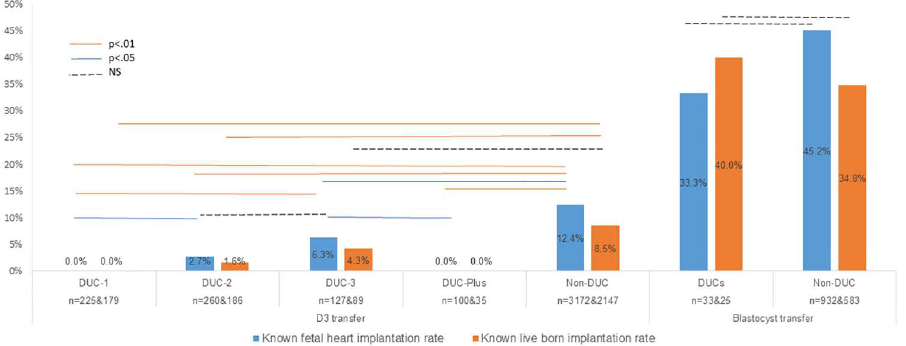
Fig 2. D3 and blastocyst transfer known implantation rate. Left: D3 transfer result. Right: Blastocyst transfer result (includingfrozen transfer cycles). DUC-1: direct unequal cleavageat 1 st cleavage;DUC-2: direct unequalcleavageat 2nd cleavage;DUC-3: direct unequalcleavageat 3 rd cleavage;DUC-Plus: DUC occurredmore than once. Non-DUC:embryos without DUC. DUCs: all DUC